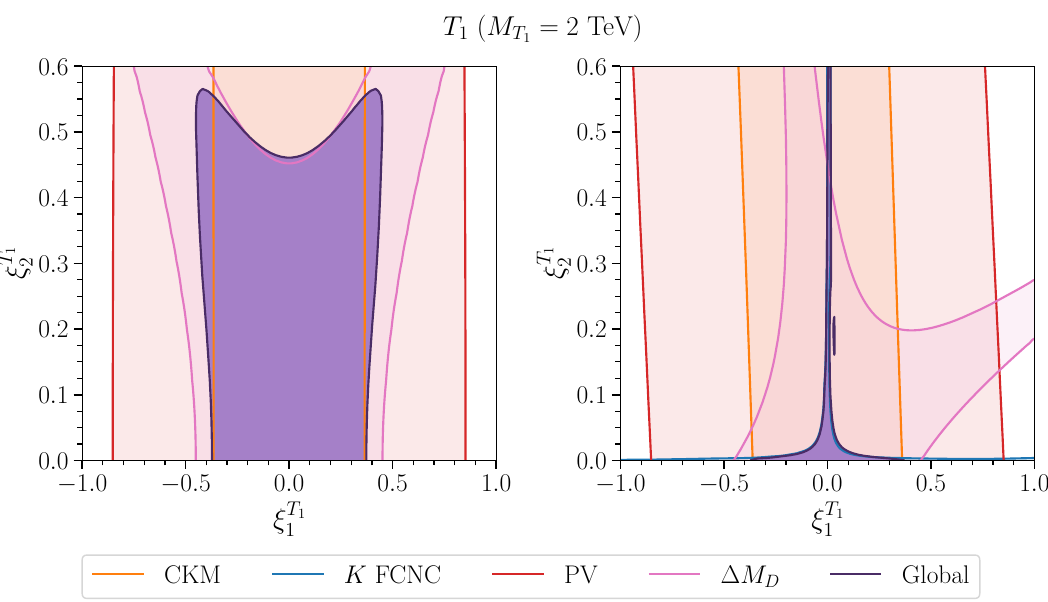
Figure 12 . Global fit to 1 st and 2 st generation couplings of the VLQ T 1 . The left-hand side assumes multiple generations of VLQs, each only coupling to a single generation (i.e. effectively removing constraints from kaon physics), while on the right side this assumption is removed.